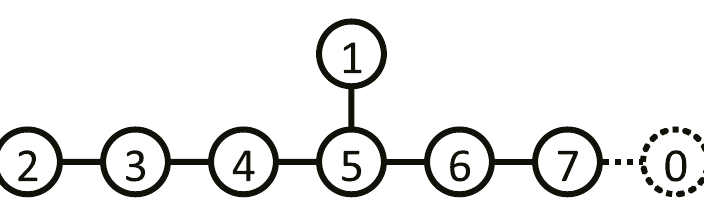
Figure 8 . The Dynkin diagram of the E 7